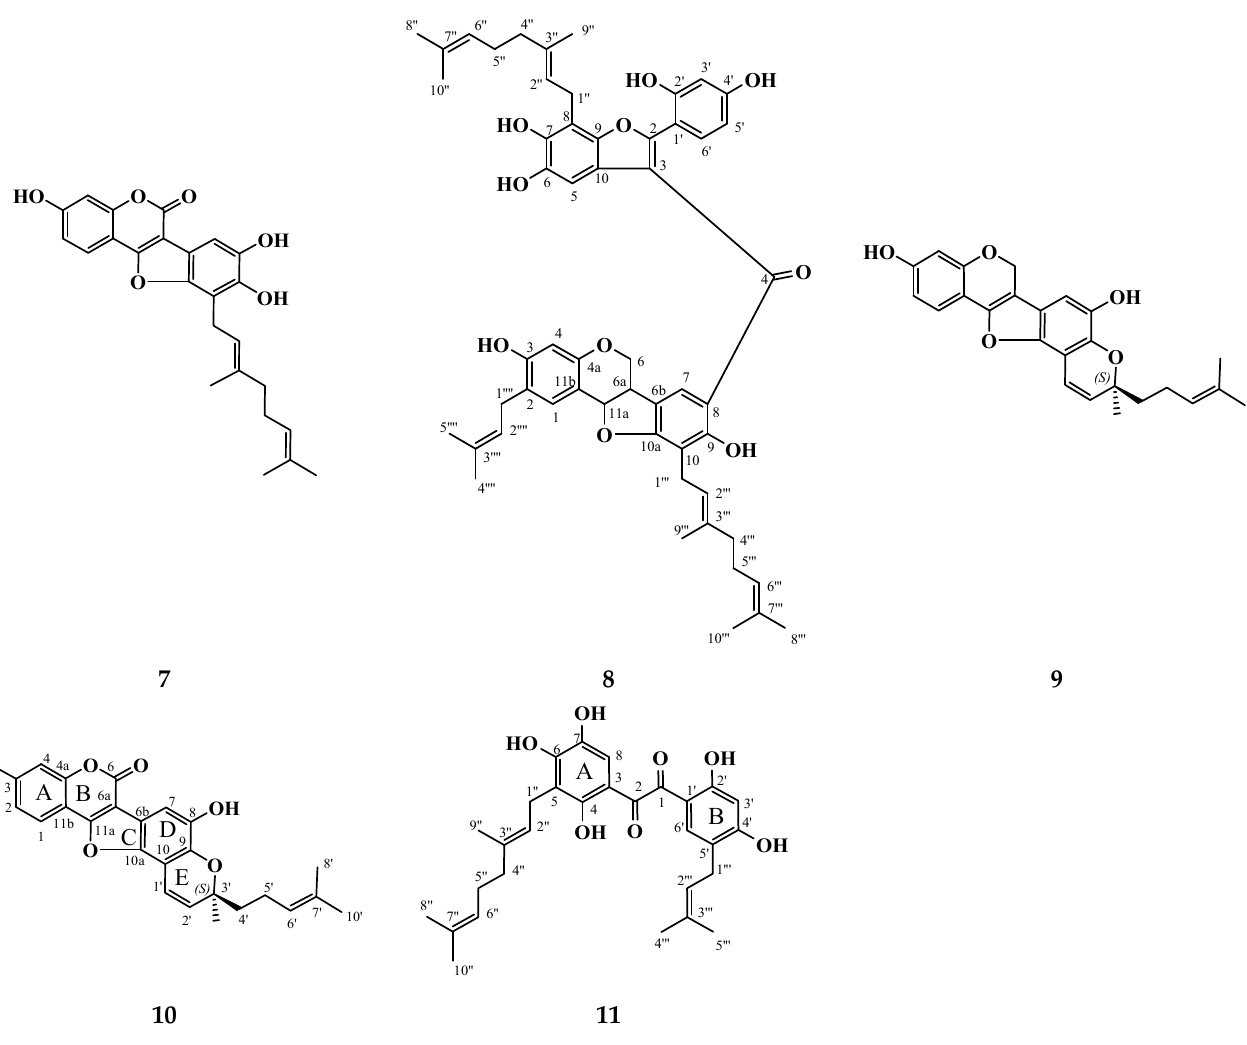
Figure 1. Structures of polyphenolic compounds isolated from L. bicolor root bark. Compound 10 was obtained as a white amorphous powder. The molecular formulae of 10 was determined to be C 25 H 22 O 6 based on the presence of [M-H] - and [M+H] + ions at m/z 417.1337 (calculated for C 25 H 21 O 6- 417.1344) and 419.1479 (calculated for C 25 H 23 O 6+ 419.1489), respectively, in the HR-MS-ESI spectrum of 10 . The 13 C spectrum of 10 contained 25 signals of carbon atoms (Table 1). Fifteen carbon atoms belonged to the coumestan skeleton (rings A–D), and 10 atoms formed a 3 (cid:48) -methyl-3 (cid:48) -isohexenylpyran ring (E). An ester carbonyl carbon signal was observed in the 13 C NMR spectrum of 10 at δ C 159.0 and was assigned to C-6 of the coumestan skeleton [22]. The 1 H NMR spectra of 10 showed the presence of an ABX spin system: the signals at δ H 7.85 (d, J = 8.5), 6.95 (d, J = 8.5), and 7.13 (s) were attributed to protons H-1, H-2, and H-4 of ring A, respectively (Table 1). A singlet signal at δ H 7.44 was ascribed to the H-7 proton (ring D of the coumestan skeleton). We also observed two broad singlet signals at δ H 6.54 and 5.50 due to OH-3 and OH-8 protons, respectively, in the 1 H NMR spectra of 10 (Table 1). The 1 H NMR spectra of 10 revealed signals at δ H 6.89 (1H, d, J = 9.9 Hz) and 5.78 (1H, d, J = 9.9 Hz) due to the H-1 (cid:48) and H-2 (cid:48) protons of the AX-type olefinic proton system, suggesting that 10 had an oxidatively cyclized geranyl side chain similar to the structures of compounds 2 and 9 (Table 1) [24]. We completely assigned all signals in the 1 H and 13 C NMR spectra of 10 on the basis of COSY, HMBC, and ROESY spectral data. Thus, compound 10 was determined to be a